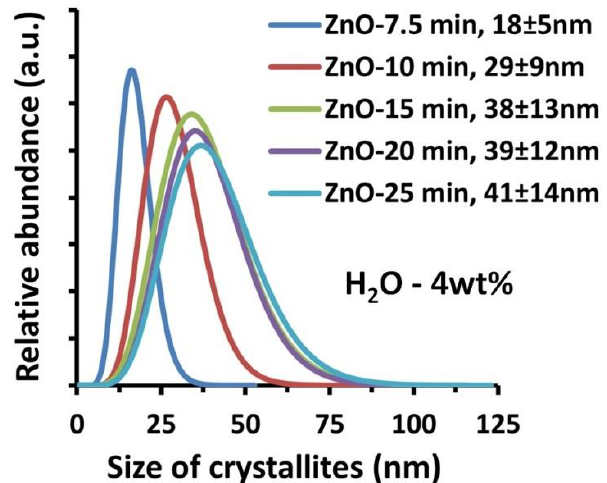
Figure 51. Crystallite size distribution for ZnO NPs samples obtained from the precursor with the 4% H 2 O content. Republished with permission of © IOP Publishing from [402], Copyright (2018), permission conveyed through Copyright Clearance Center, INC. All rights reserved. In order to re-use permission must be obtained from the rightsholder.